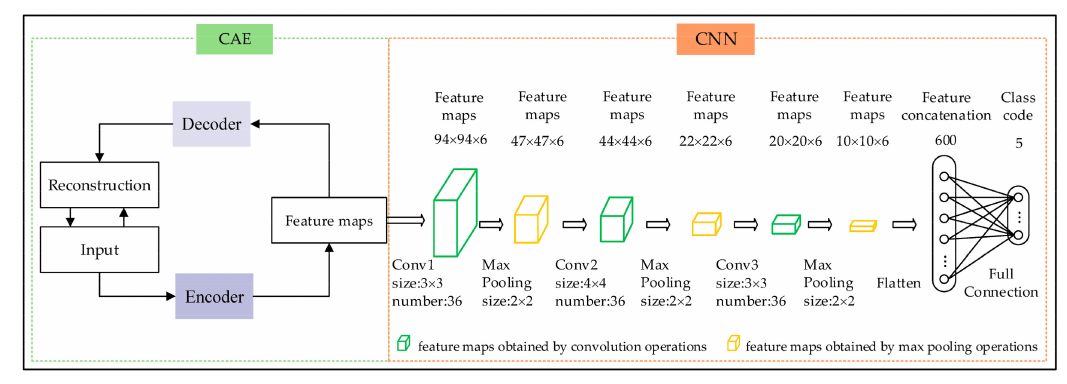
Figure 2. Architecture of the CAE_CNN model (the green layers represent the feature maps obtained by convolution operations, and the yellow layers represent the feature maps obtained by max pooling operations).